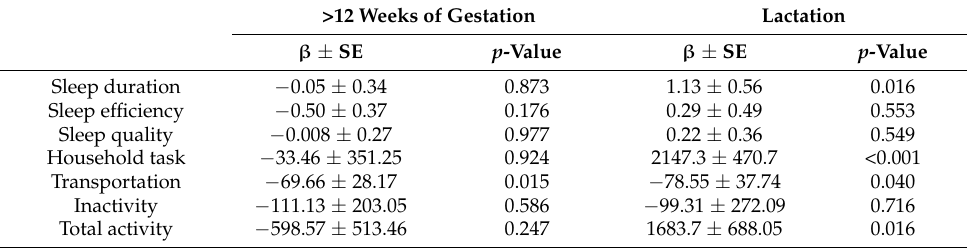
Table 4. Association between sleep and physical activity with pregnancy and lactation. >12 Weeks of